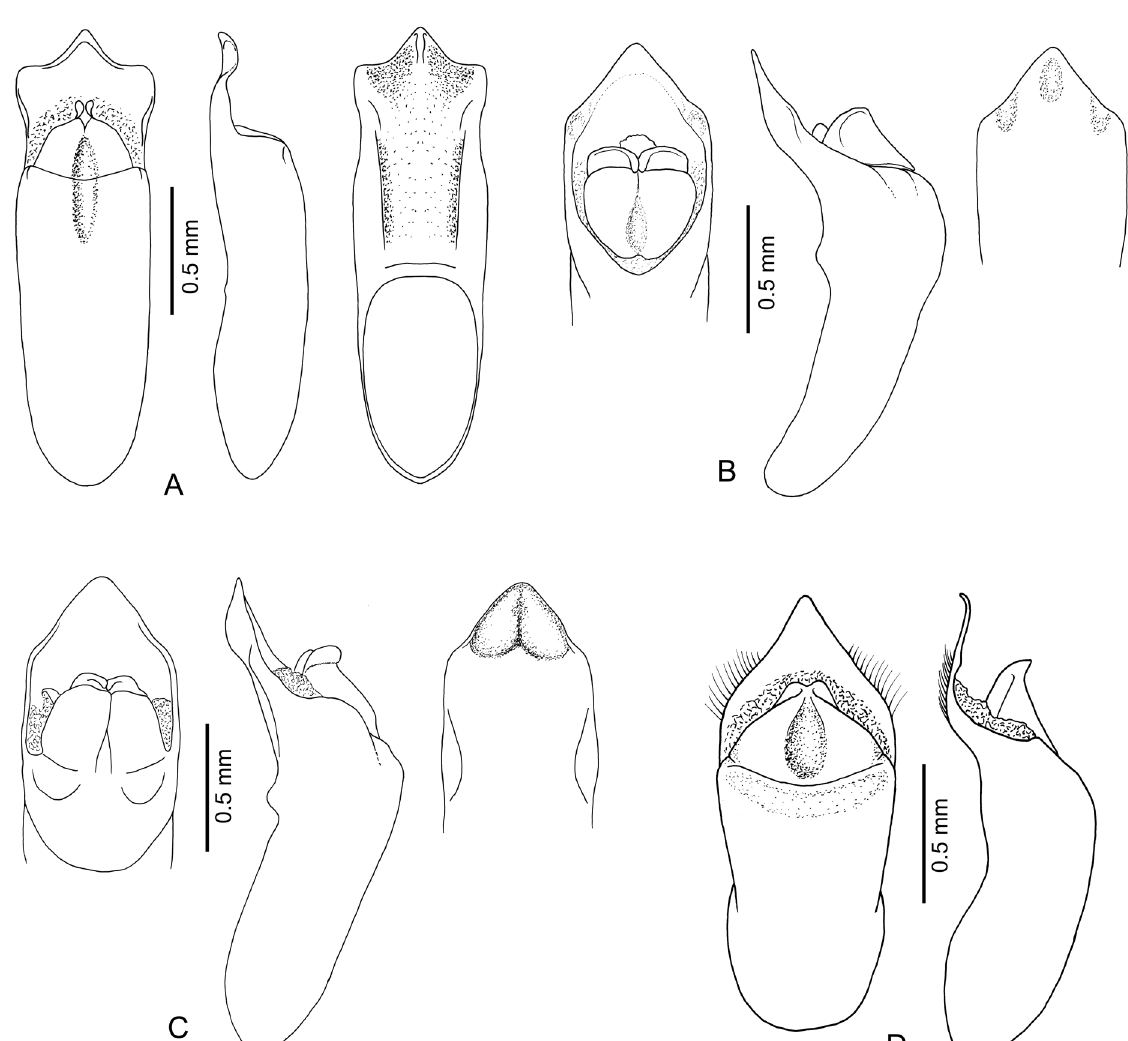
Fig. 7. Aedeagus in dorsal, lateral and ventral views. A . Tituboea harteni Bezděk sp. nov. B . T. lacordairei (Pic, 1929). C . T. ogloblini (Medvedev, 1962). D . T. pindai Bezděk,